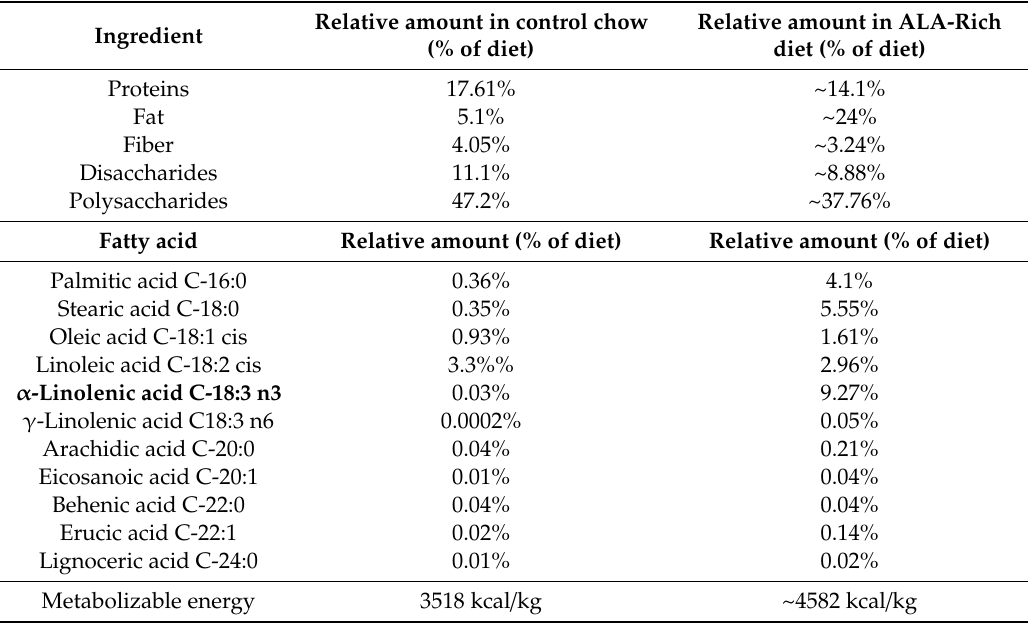
Table 1. Composition and fatty acid profile of the standard Altromin 1814 laboratory chow and ALA-rich diet.